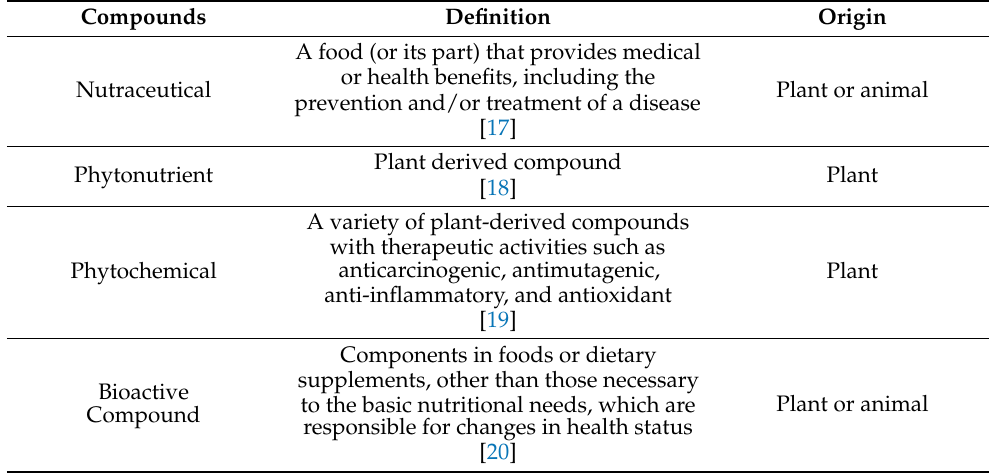
Table 1. Classification of compounds that can be used in poultry production.